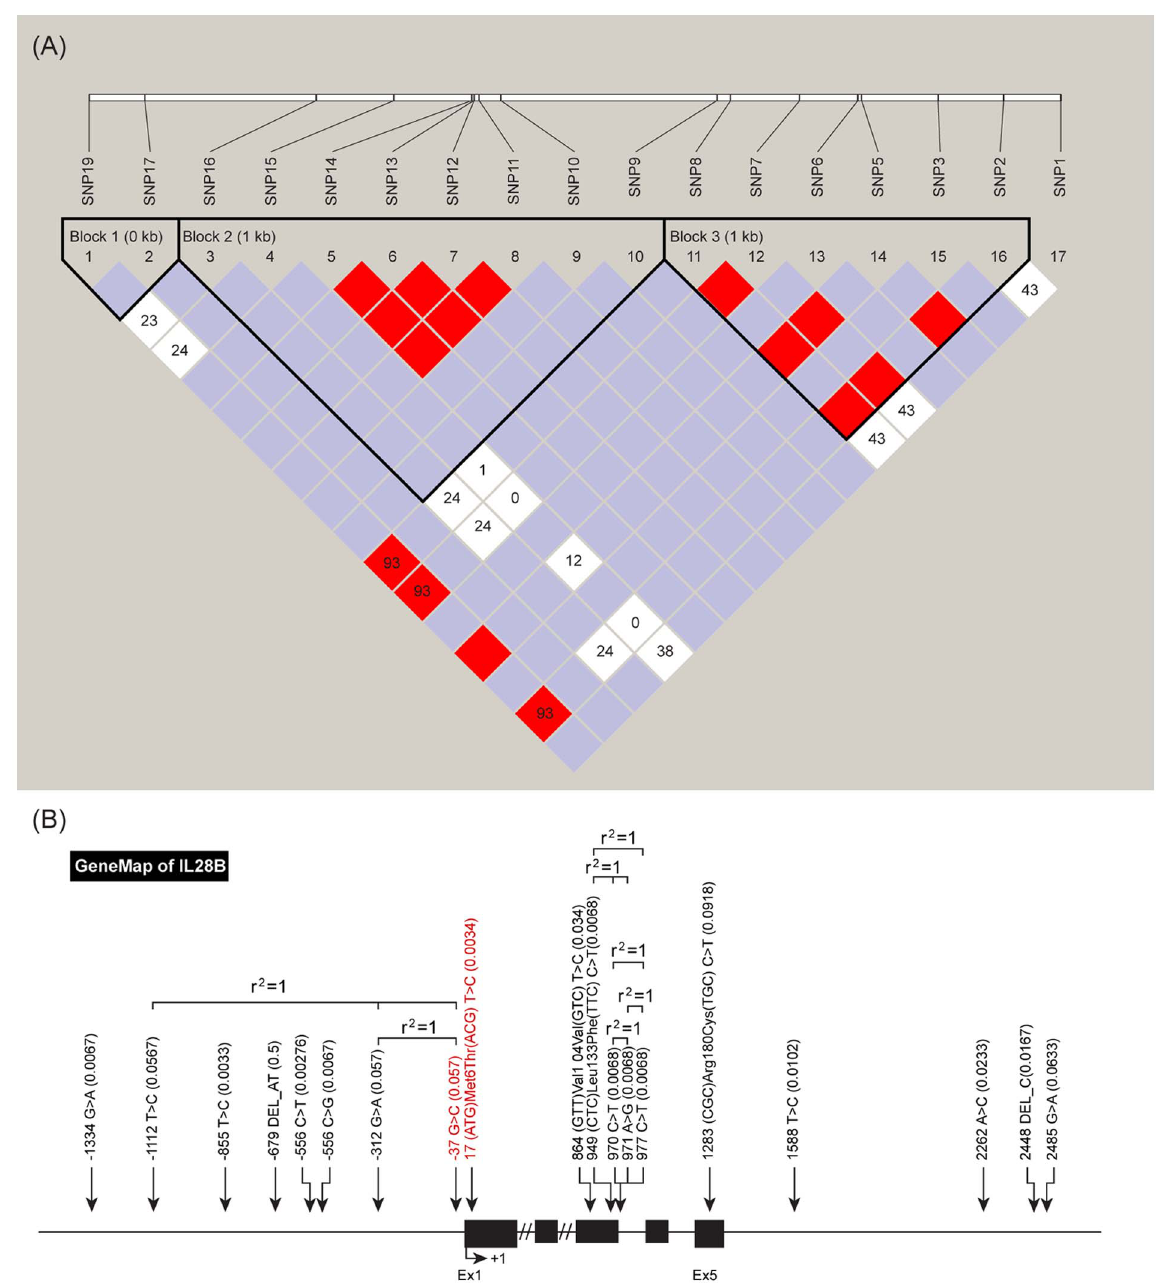
Figure 1. Genomic position of novel SNPs in the IL28B coding region (A) and linkage disequilibrium map (B). Among the 19 novel SNPs identified, the proportion of 6 SNPs (SNP 2, 5, 7, 8, 17, and 19) were significantly different among the UE, SC, and CC groups (all P ,